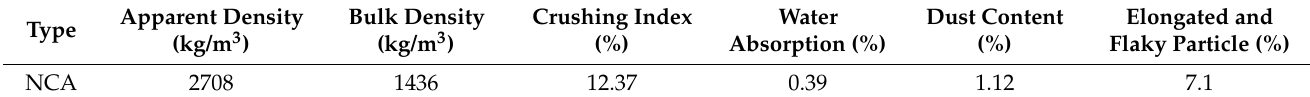
Table 2. Performance indexes of natural coarse aggregate.